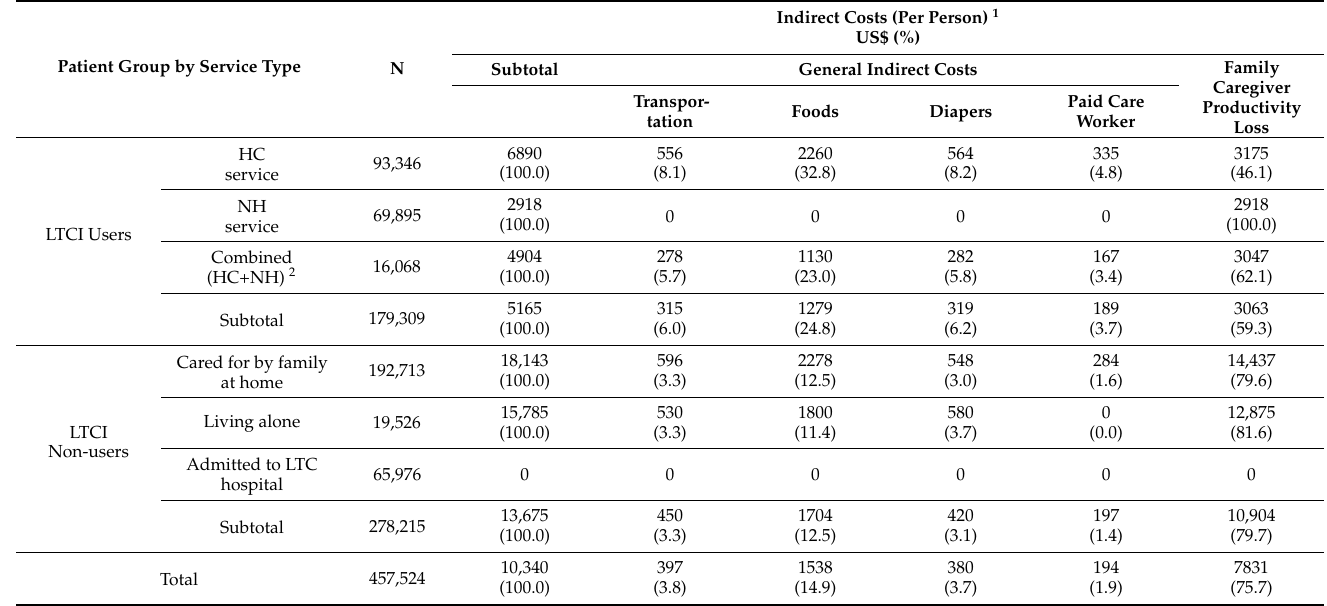
Table 4. Per-Person Indirect